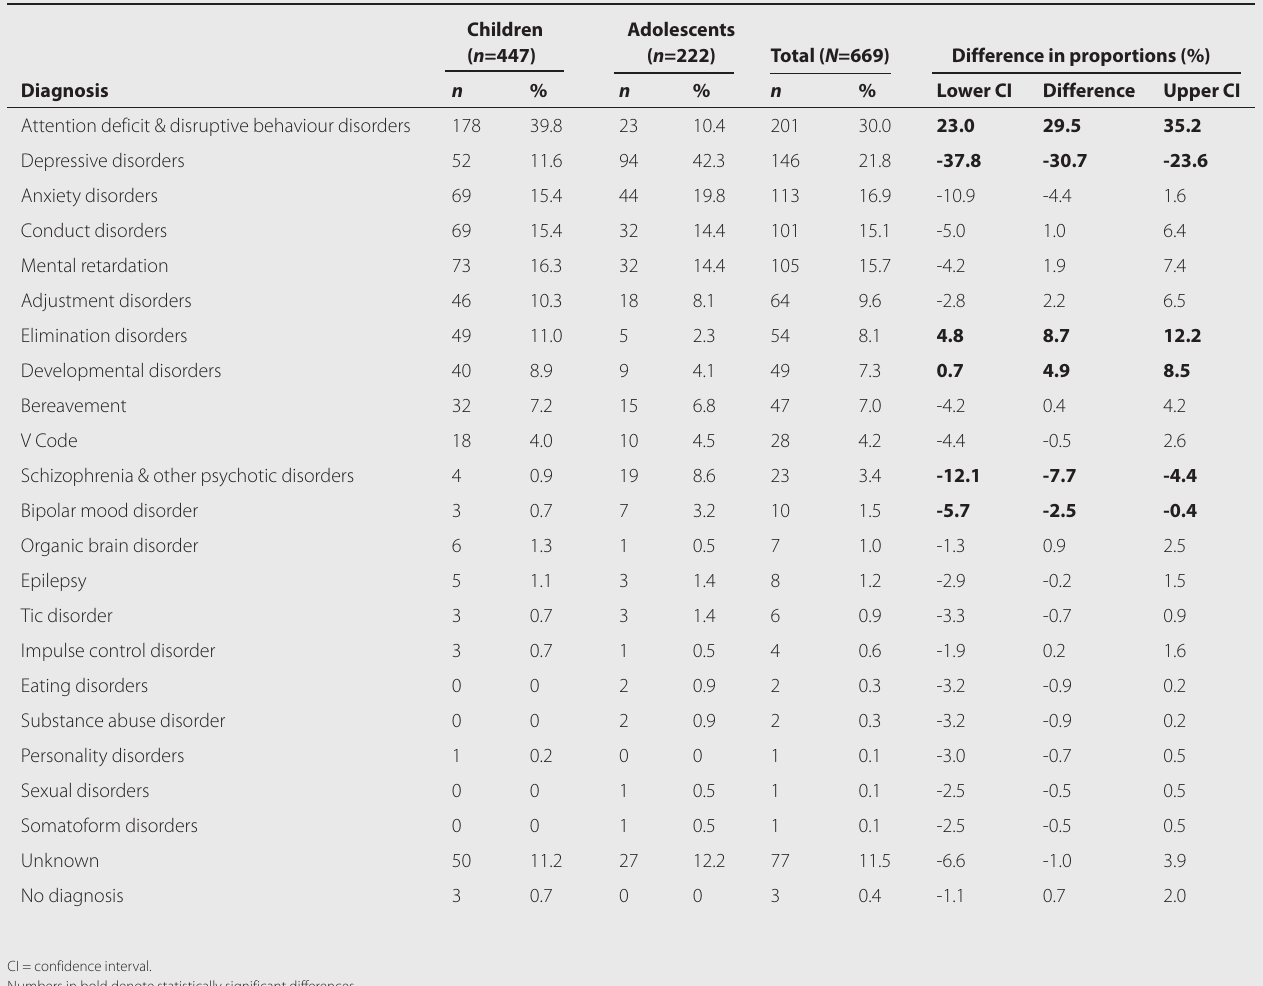
Table 3. Diagnoses in children and adolescents seen at the Child and Adolescent Unit of the FSPC from January 2006 to December 2007